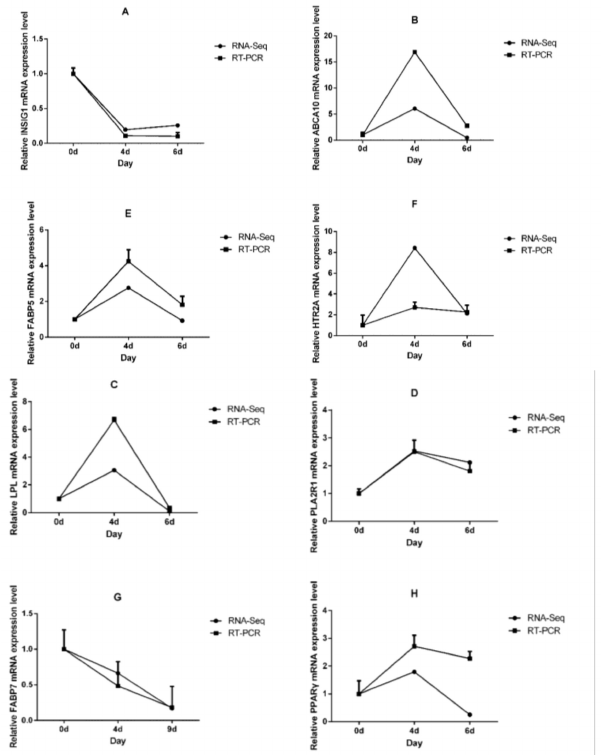
Figure 3. RT-qPCR validation of the DEGs from RNA sequencing. ( A ): Insulin induced gene 1 (INSIG1); ( B ): ATP binding cassette subfamily A member 10 (ABCA10); ( C ): Lipoprotein Lipase (LPL); ( D ): Phospholipase A2 receptor 1 (PLA2R1); ( E ): Fatty acid binding protein 5 (FABP5); ( F ):5-hydroxytryptamine receptor 2A (HTR2A); ( H ): Fatty acid binding protein 7, (FABP7); ( G ): peroxisome proliferator activated receptor gamma (PPAR γ ); β -actin was chosen as the internal control genes. Each experiment was carried out in triplicate. The solid black circle and square represented differential expression multiple from sequencing and